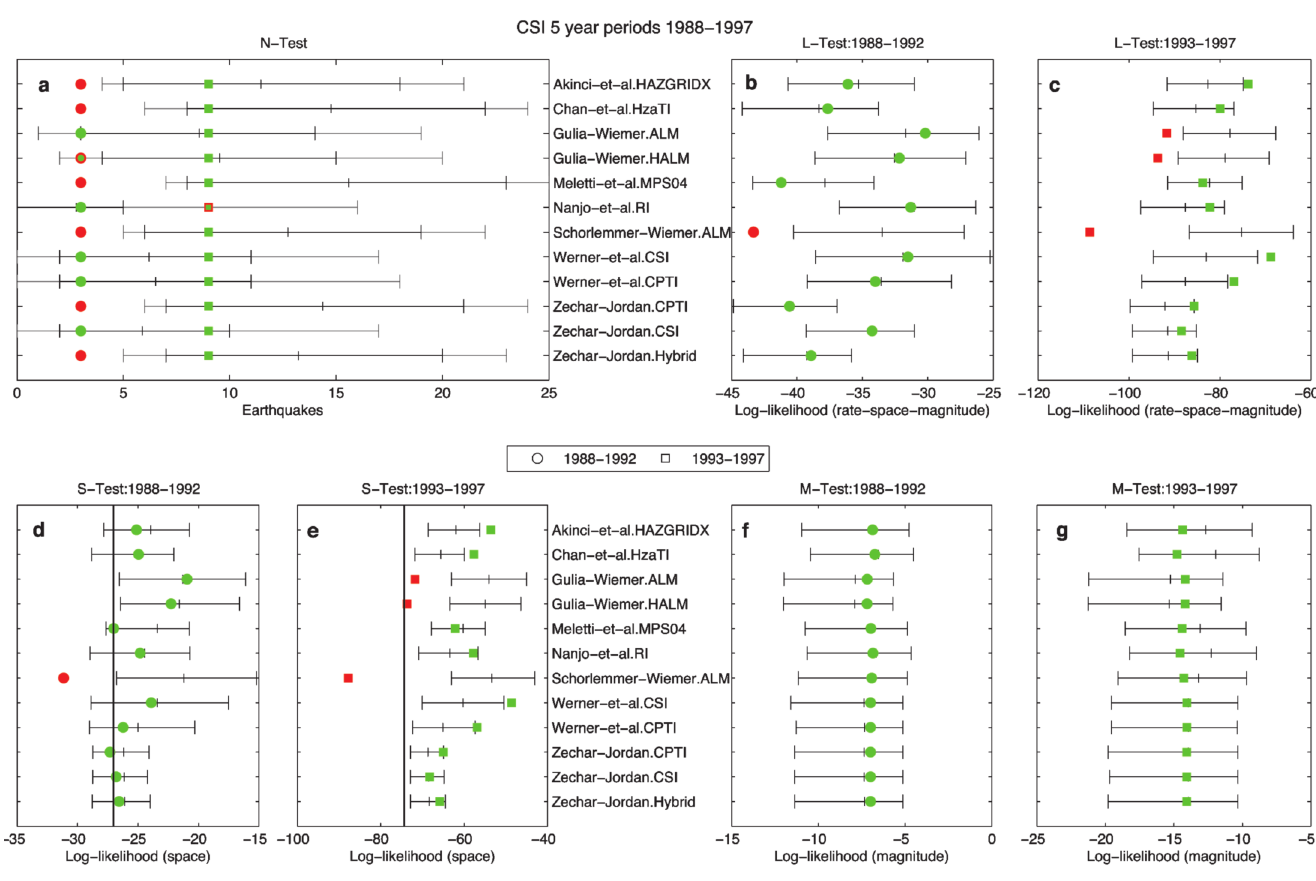
Figure 3. Results of the (a) N-Test, (b-c) conditional L-Test, (d-e) S-Test, and (f-g) M-Test of the 5-year time-independent forecasts using two separate 5-year target periods of the data from the CSI. Symbols and bars as given in the legend to Figure